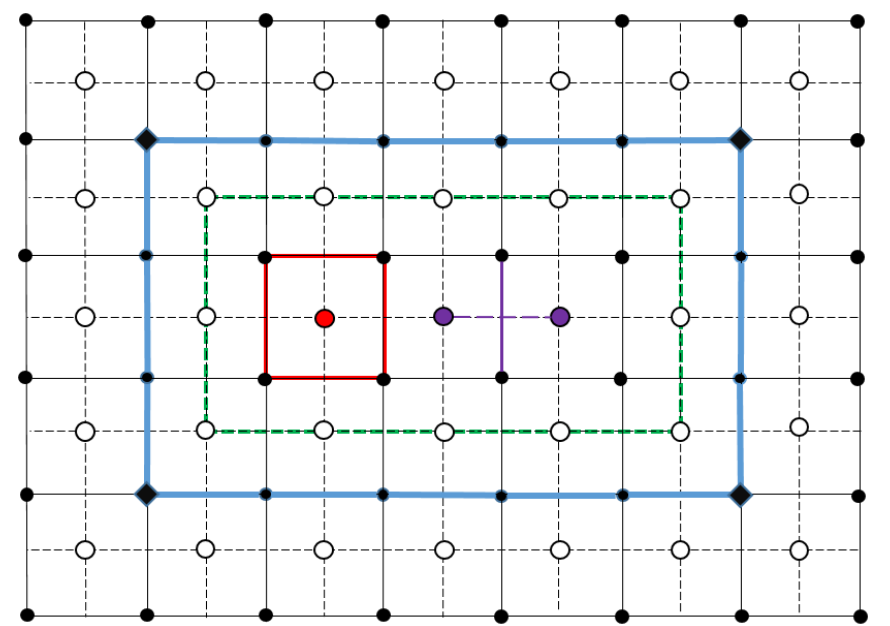
Figure 1 . The two-dimensional lattice for the gauge theory (shown with solid lines) and the dual lattice for the scalar theory (shown with broken lines). Under duality, the electric operator along the solid violet link is mapped to the di(cid:11)erence of (cid:30) ’s at the two violet vertices and the Wilson loop along the boundary of the plaquette shown in solid red is mapped to (cid:25) at the centre of the plaquette shown in red. The blue rectangle encloses the region R , with the four atypical boundary points at the edges shown as diamonds. The green rectangle encloses the dual region ~ R